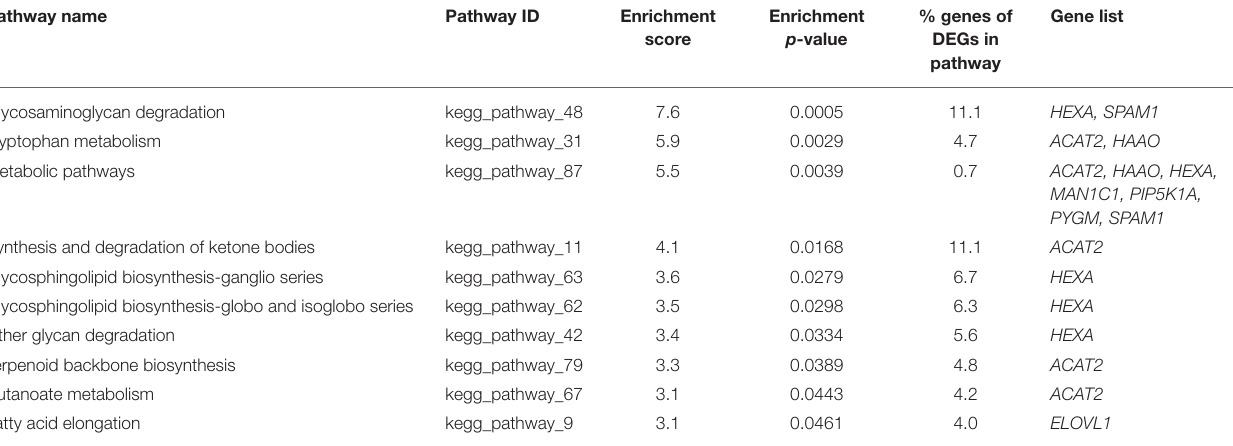
TABLE 3 | Enrichment analysis of pathways for up-regulated differentially expressed genes in vitrified morulae.